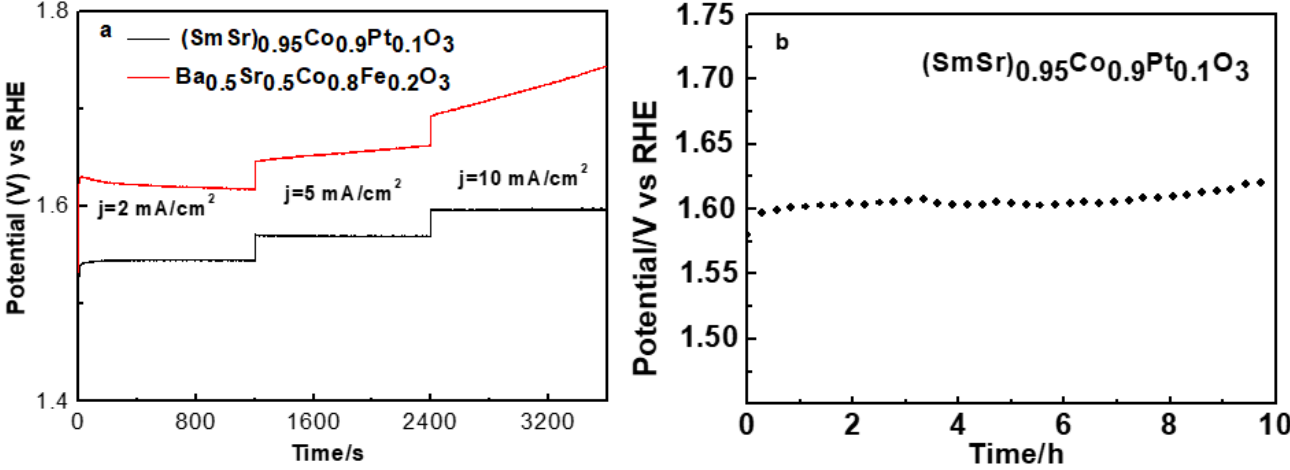
Figure 8. Chronopotentiometry of (SmSr) 0.95 Co 0.9 Pt 0.1 O 3 and Ba 0.5 S r0.5 Co 0.8 Fe 0.2 O 3 ( a ). Stability plots for (SmSr) 0.95 Co 0.9 Pt 0.1 O 3 and Ba 0.5 S r0.5 Co 0.8 Fe 0.2 O 3 , measured at different current densities. ( b )